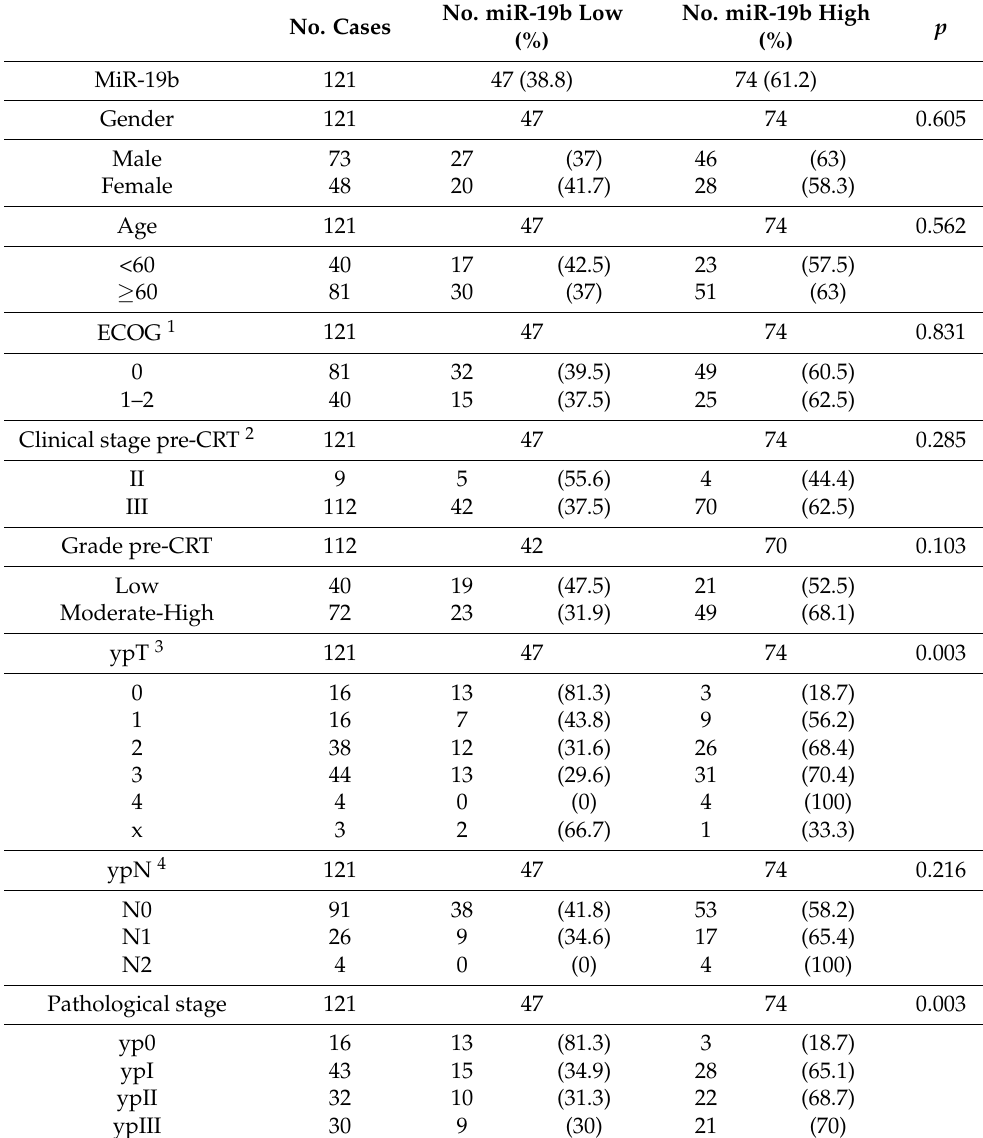
Table 1. Association between clinical and molecular parameters and miR-19b expression levels in a cohort of 121 locally advanced colorectal cancer (LARC)